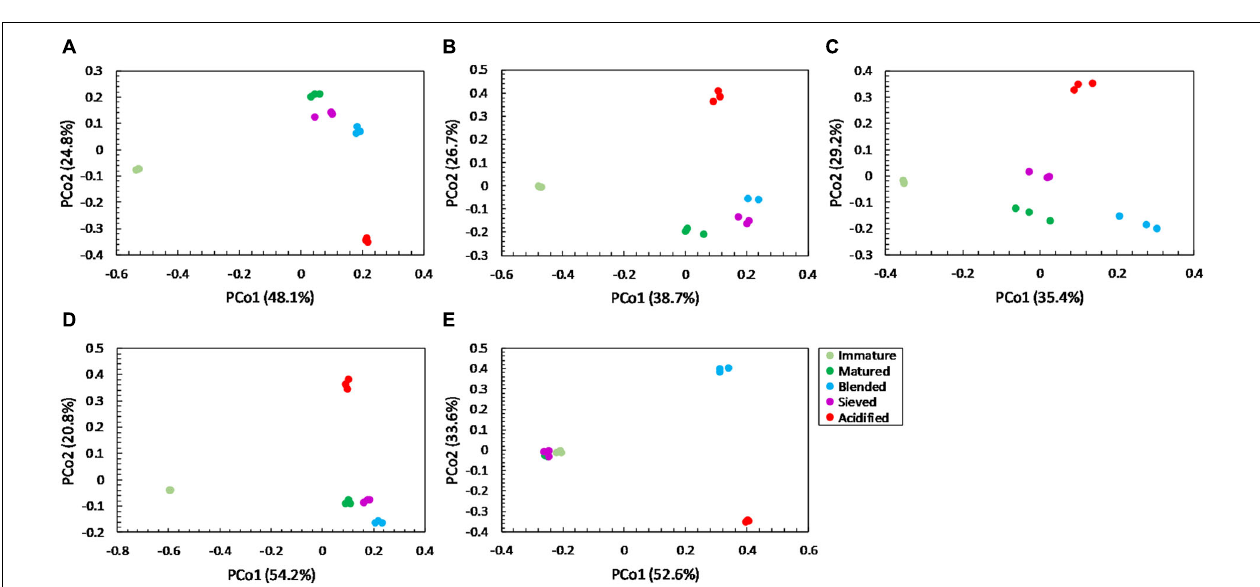
FIGURE 4 | Microbial diversity in immature and matured composts in the five compost batches. On top: mean bacterial diversity ± standard error in the five compost batches, calculated as the Shannon diversity index from 16S V3-V4 rRNA gene sequencing data. At the bottom: mean fungal diversity ± standard error in the five compost batches, calculated as the Shannon diversity index from ITS2 gene sequencing data.